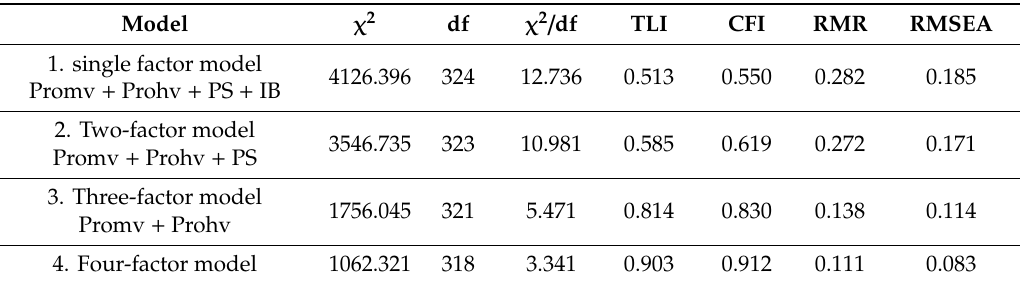
Table 1. Confirmatory factor analysis ( n = 374).